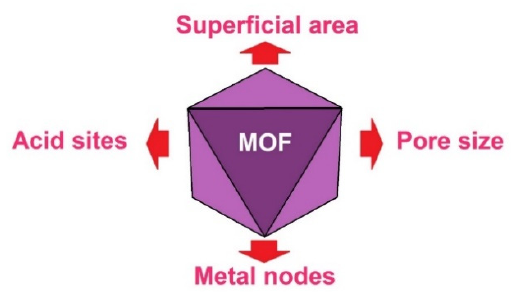
Figure 3. Relevant parameters to be considered in the preparation of MOFs, which will be used as catalysts in biomass transformation.